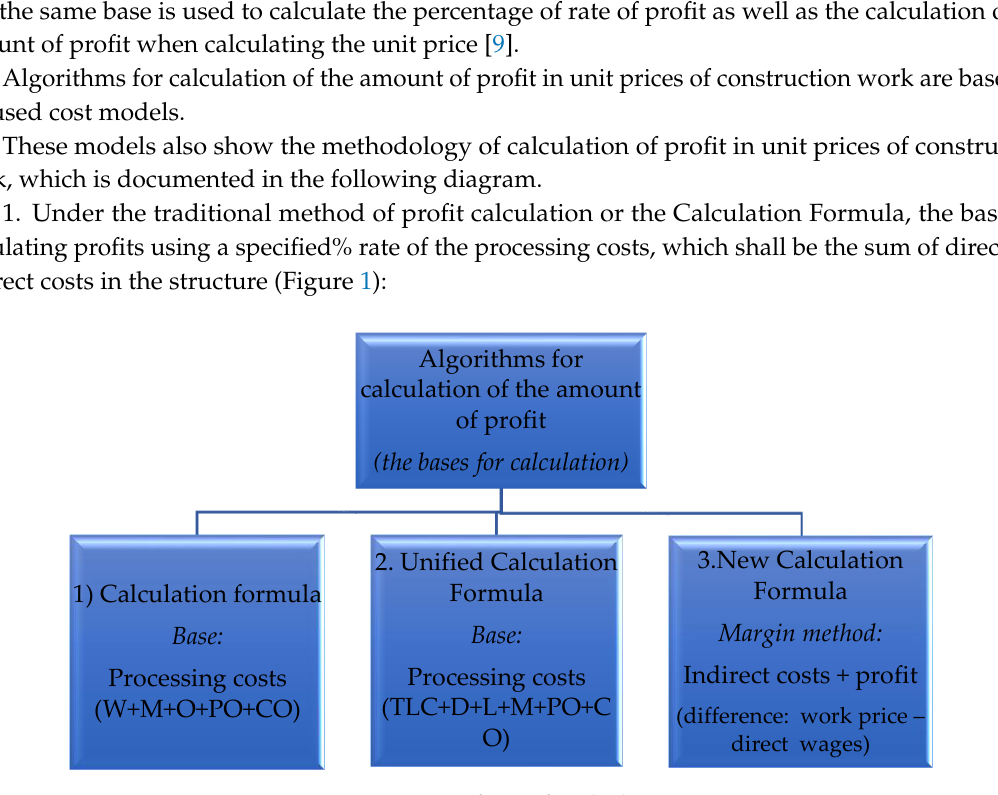
Figure 1. Basis for profit calculation.